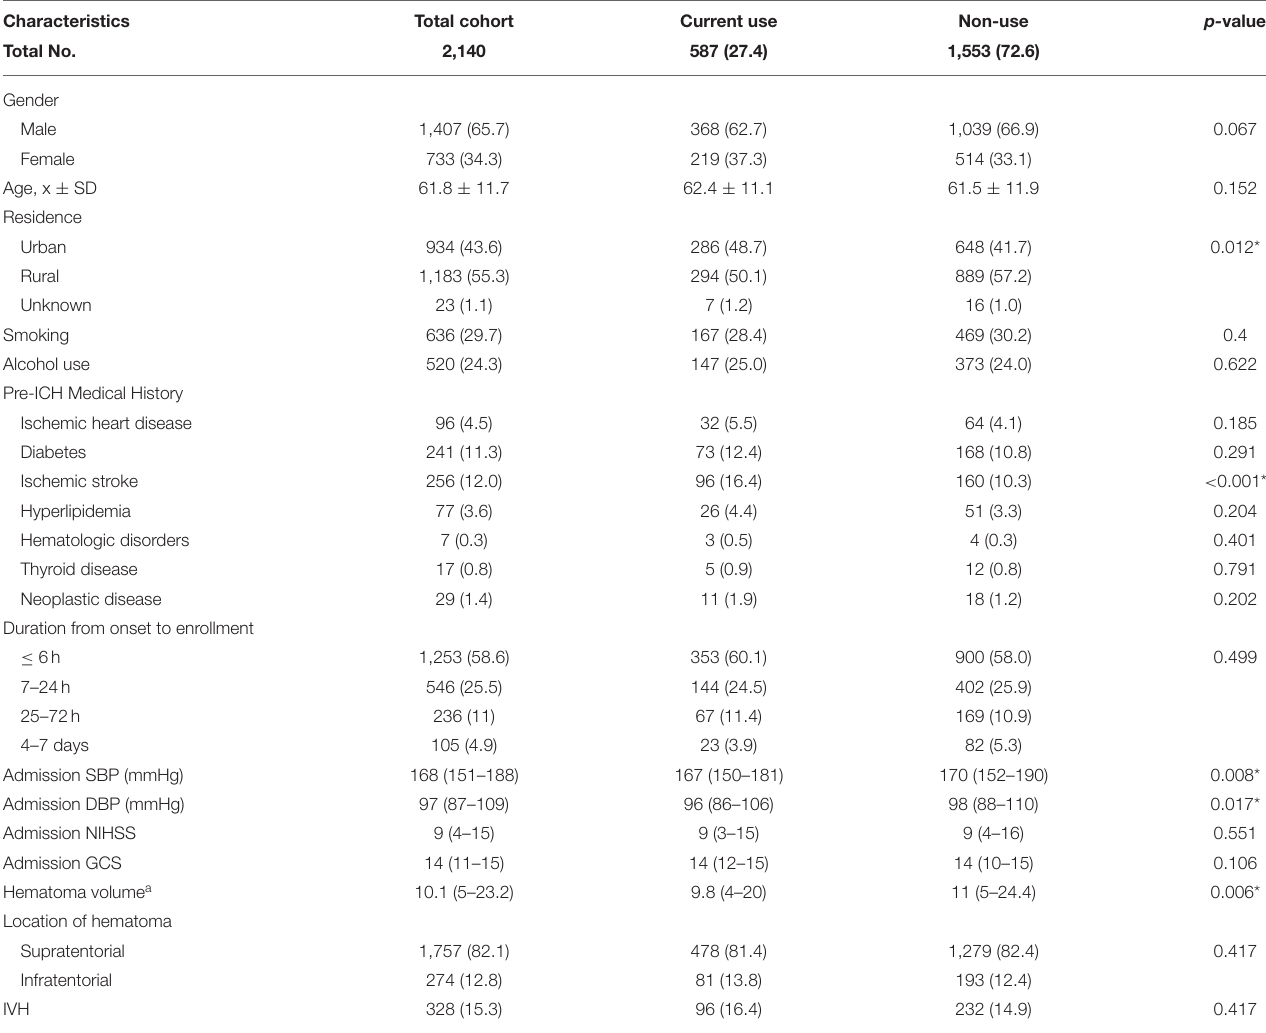
TABLE 1 | Demographic and clinical characteristics of the